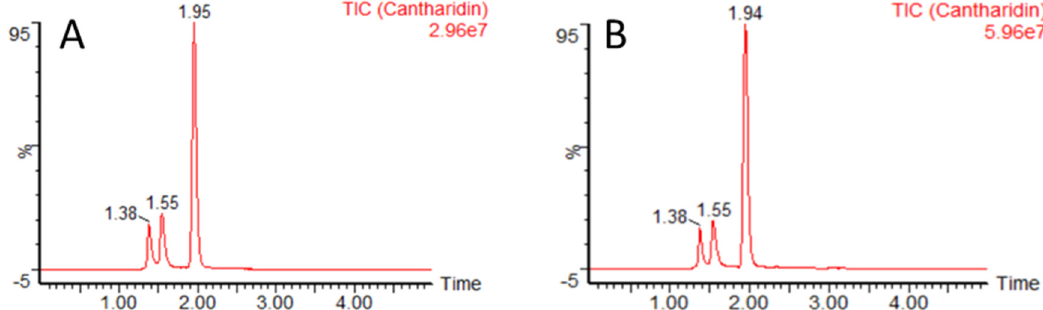
Figure 1. Chromatogram of cantharidin in blister beetle in the sample, spiked at the limit of quantification (LOQ) of 0.6 ng/mg ( A ) and in the positive beetle sample of Mylabris variabilis (concentration was above or equal to LOQ) ( B ). The retention time of cantharidin was at 1.95 min.